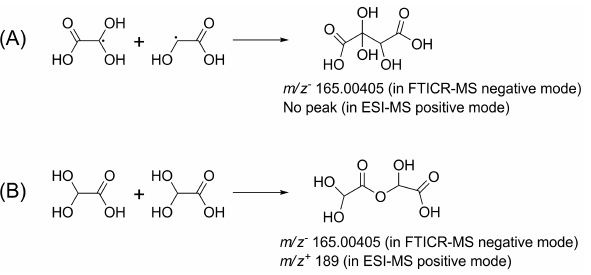
Fig. 6. MW 166 organic product formed through a radical-radical reaction (A) or acid catalysis (B)